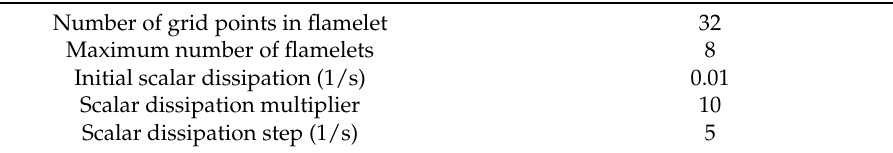
Table 3. Flamelet parameters.